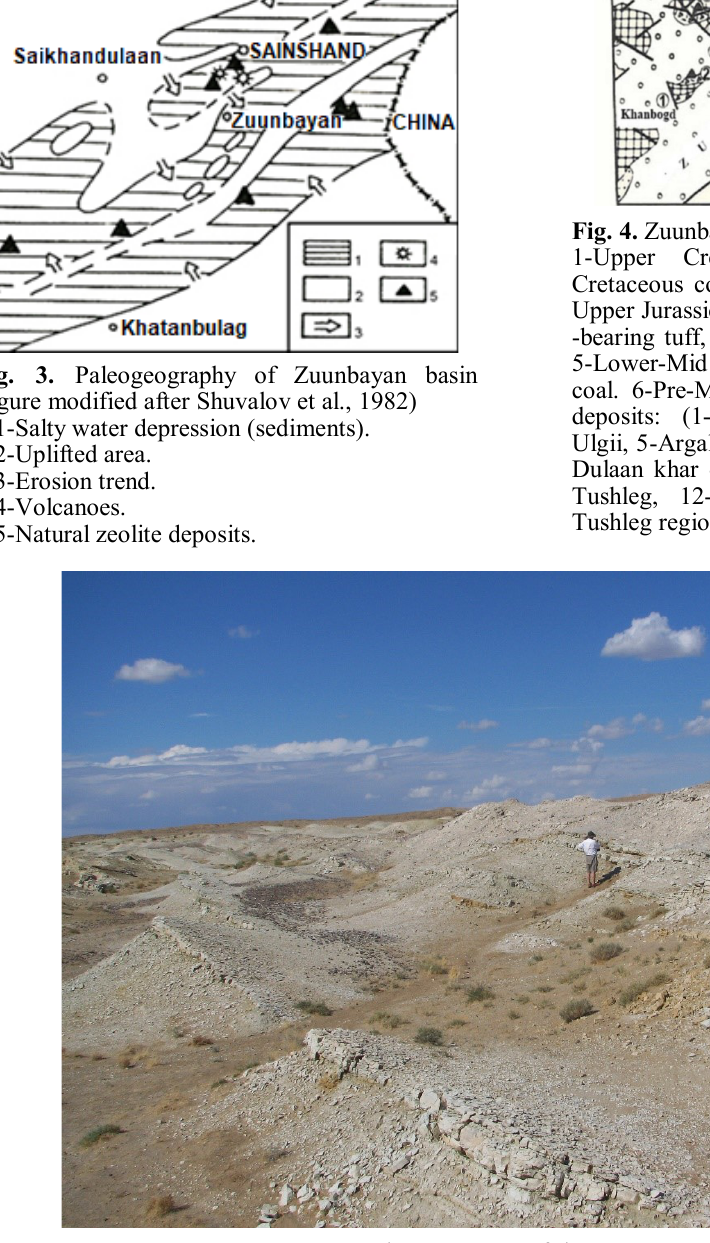
Fig. 5. General appearance of the Tsagaantsav zeolite